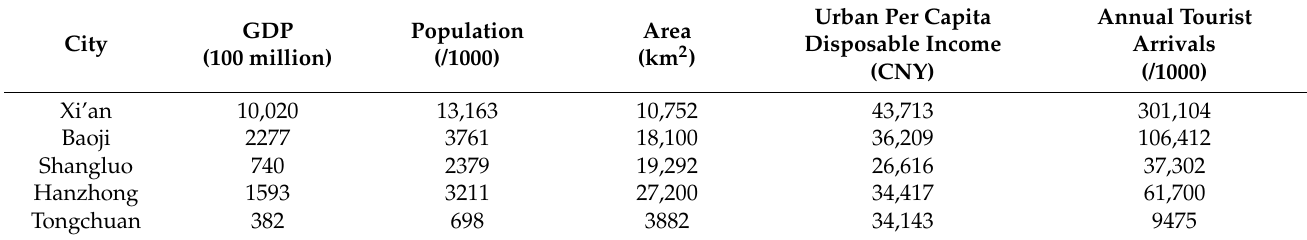
Table A1. Statistics of WTEZ